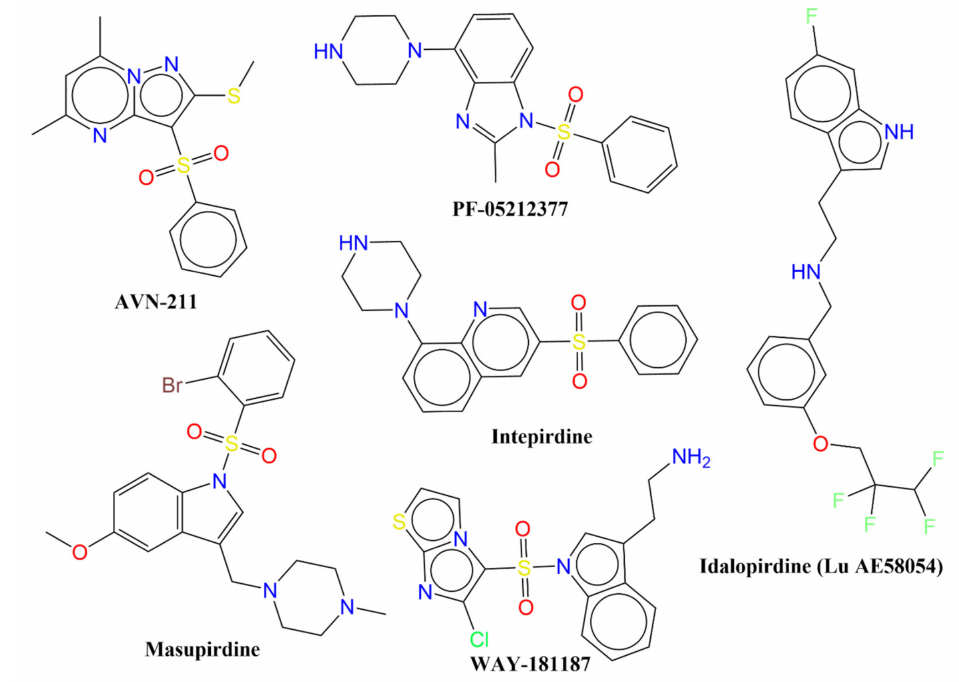
Figure 1. Chemical structures of representative examples of clinically tested 5-HT6